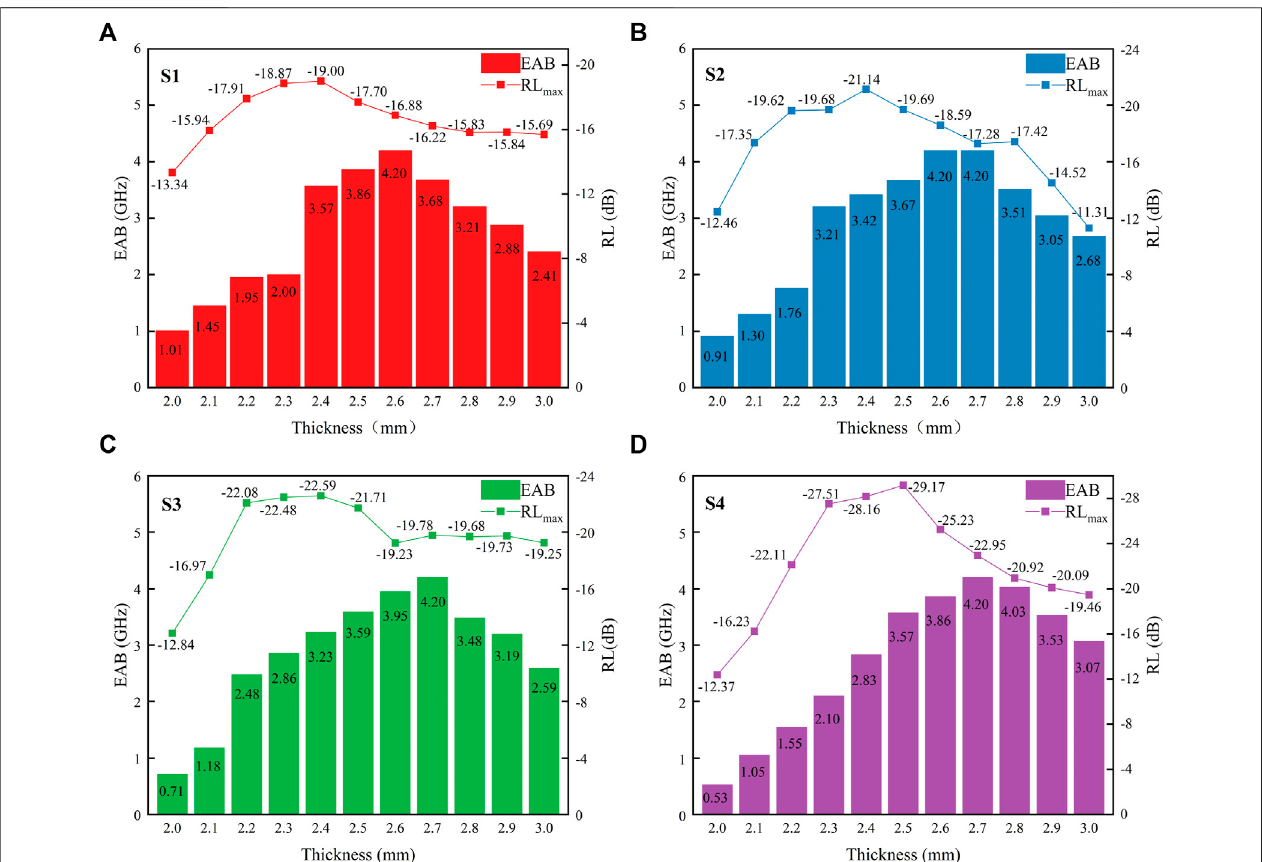
FIGURE 6 | Maximum RL and EAB of (A) S1, (B) S2, (C) S3 and (D) S4.